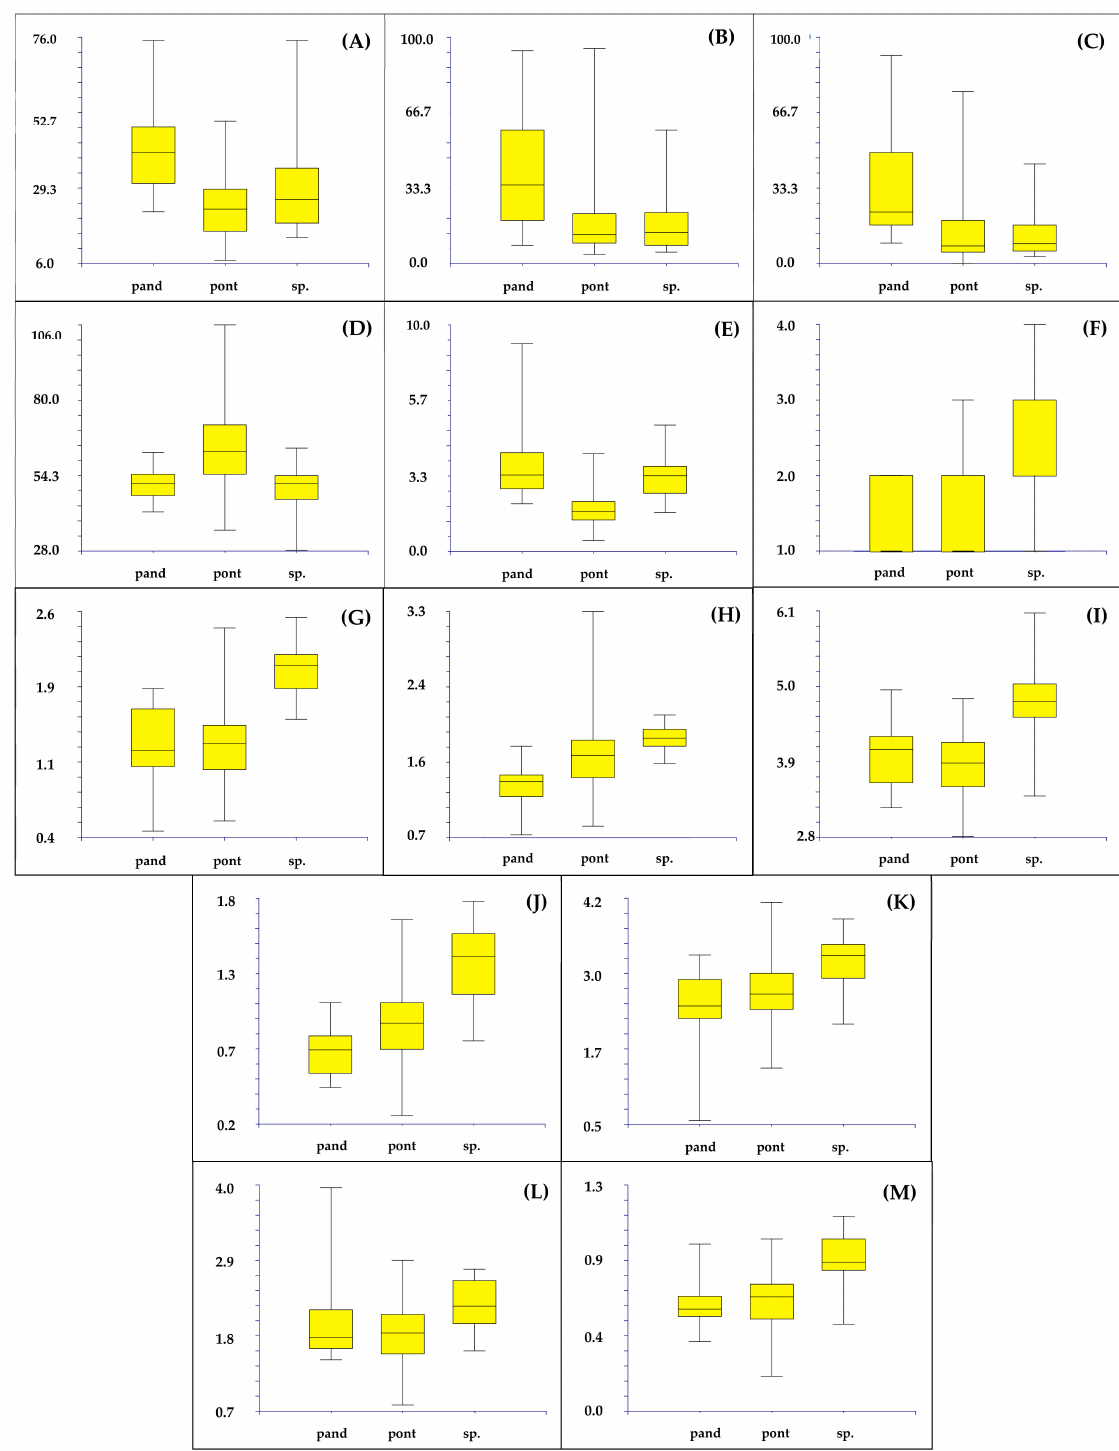
Figure 9. Box plots illustrating the variability of the diagnostic character derived from PCA: length of the leaves ( A ), number of fertile ( B ) and sterile ( C ) branches, average angle between branches ( D ), length of the ludicule ( E ), number of flowers per spikelet ( F ), length of the outer ( G ), middle ( H ), and inner ( I ) bracts, width of the middle ( J ) and inner bracts ( K ), length of limb ( L ), and width of the calyx lobes ( M ) (measurements are in mm). pand = L. pandatariae ; pont = L. pontium ; sp. = Terracina population. Yellow boxes illustrate interquartile ranges (=the range between the 25th and 75th percentile) and medians (horizontal line); vertical lines are the whiskers which represent the scores outside the middle 50% (i.e., the lower 25% of scores and the upper 25% of